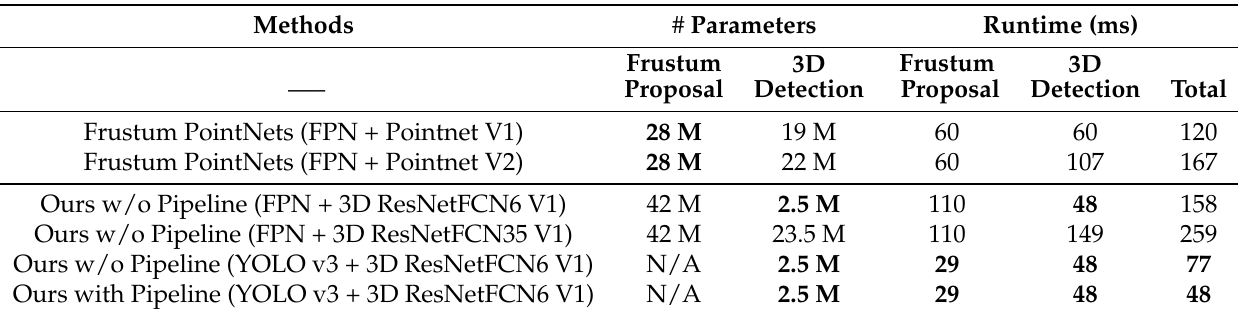
Table 6. Number of parameters and inference time comparison between Frustum Pointnet and our system. For YOLO v3, input resolution is 416 by 416 and the model FLOPS is 65.86